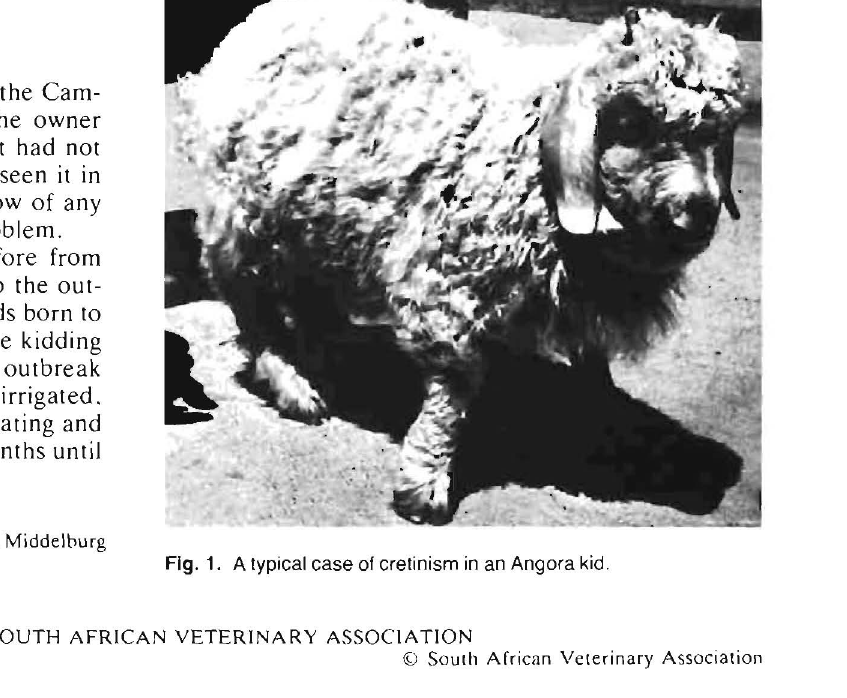
Fig. 1. A typical case of cretinism in an Angora